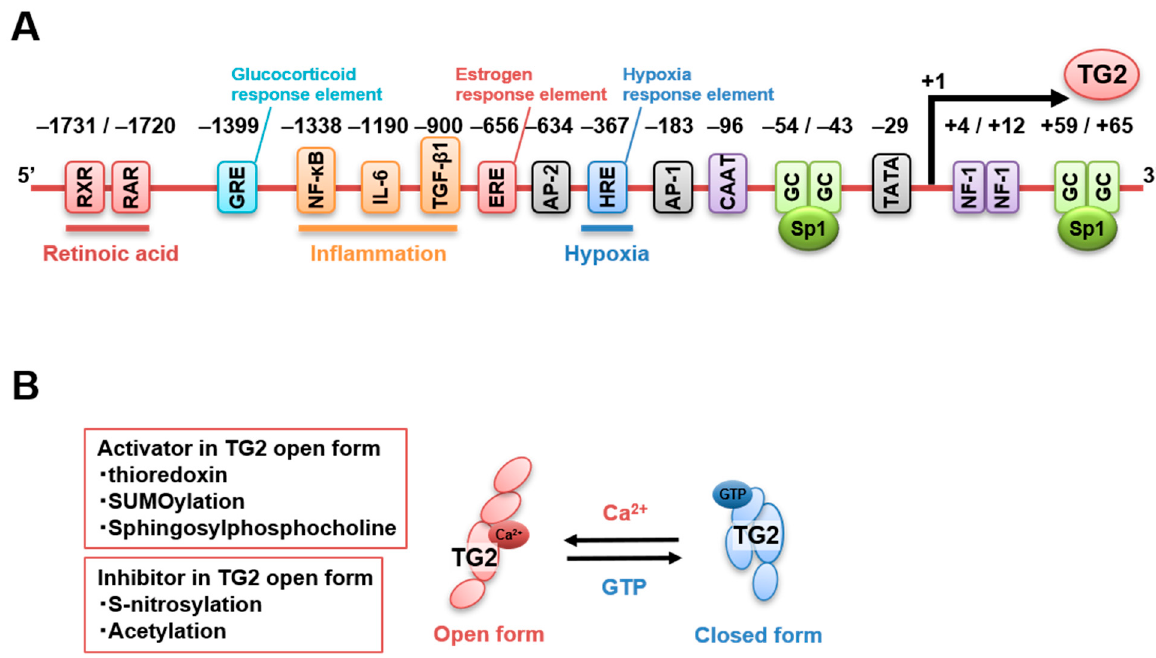
Figure 2. Regulation of TG2 expression and activity. ( A ) Several factors bind to the TGM2 promoter and regulate TGM2 expression. Response elements binding sites for retinoic acid, RXR/RAR ( − 1731 bp and − 1720 bp), glucocorticoids, GRE ( − 1399 bp), NF- κ B ( − 1338 bp), IL-6 ( − 1190 bp), TGF- β 1 ( − 900 bp), estrogens, ERE ( − 656 bp), activator protein-2, AP-2 ( − 634 bp), hypoxia: HRE ( − 367 bp), activator protein-1, AP-1, and nuclear factor-1 (+4 bp, +12 bp) as well as motif regions such as CAAT box ( − 96 bp), TATA box ( − 29 bp), GC box, (Sp1, − 54 bp, − 43 bp, +59 bp, +65 bp) are indicated. ( B ) The balance between open and closed TG2 structural conformations is mainly regulated by Ca 2+ and GTP concentrations. In the open conformation, TG2 transamidase activity is enhanced by thioredoxin, SUMOylation, and membrane lipids (sphingo- sylphosphocholine), whereas it is inhibited by S-nitrosylation and acetylation.